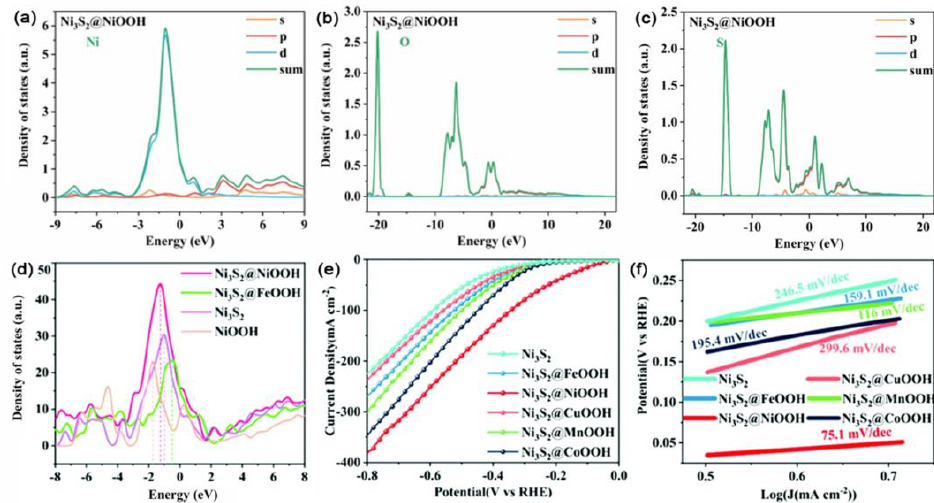
Figure 13. Density of states for Ni 3 S 2 @NiOOH, ( a ) Ni, ( b ) O, and ( c ) S. ( d ) Density of states of H 2 O for Ni 3 S 2 , NiOOH, Ni 3 S 2 @NiOOH, and Ni 3 S 2 @FeOOH. ( e ) Polarization curves for HER at a scan rate of 5 mV s − 1 in 1.0 M KOH and ( f ) the corresponding Tafel plots [121]. Copyright 2021, The Royal Society of Chemistry.